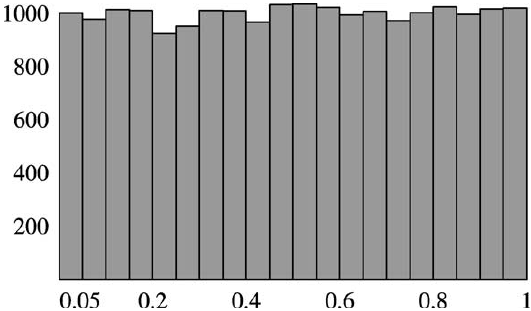
Fig. 6. Histogram of 20,000 p -values when all genes are not differ- entially